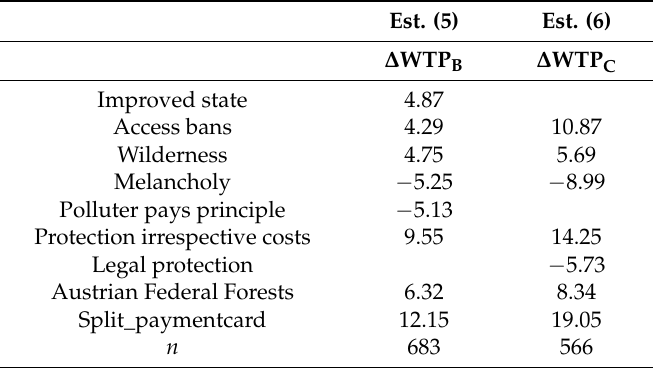
Table 6. Willingness to pay for selected scenario attributes ( € per respondent), based on scenarios B Table 5; the elasticities were calculated by the following equation: ε x = β x · x / y ; the marginal WTP was computed by holding all other variables at mean values while changing the respective variable value from 0–1; for mean values of the variables, see Table